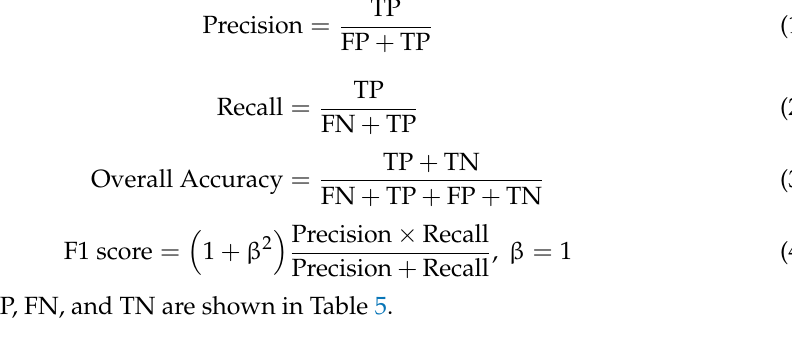
Table 5. Confusion